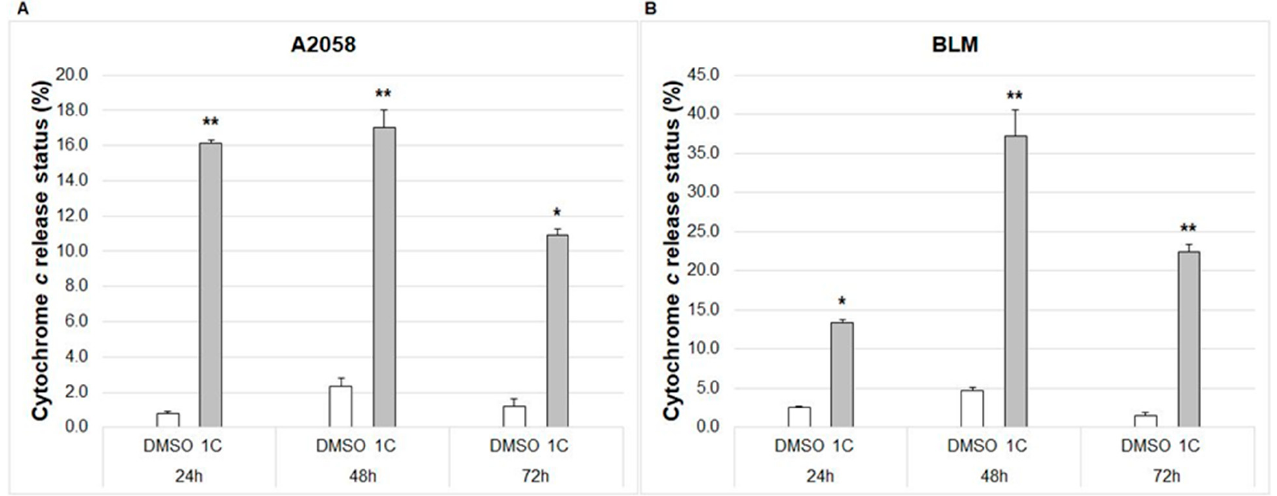
Figure 8. Flow cytometric analysis of released cytochrome c in A2058 ( A ) and BLM ( B ) melanoma cells after 24, 48 and 72 h of treatment with chalcone 1C at concentrations of 10 μ mol/L (A2058) and 20 μ mol/L (BLM). The data show the mean ± SD values of three independent experiments. Statistical significance: * p < 0.05, ** p < 0.01 vs. DMSO (vehicle).